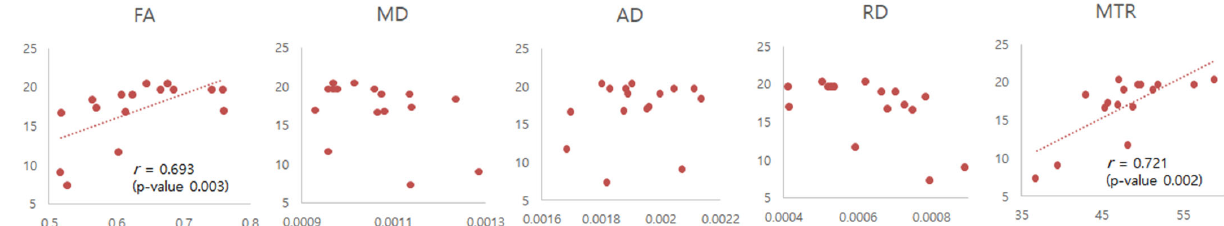
Figure 5. Correlation between MR parameters and lateral pinch at lateral corticospinal